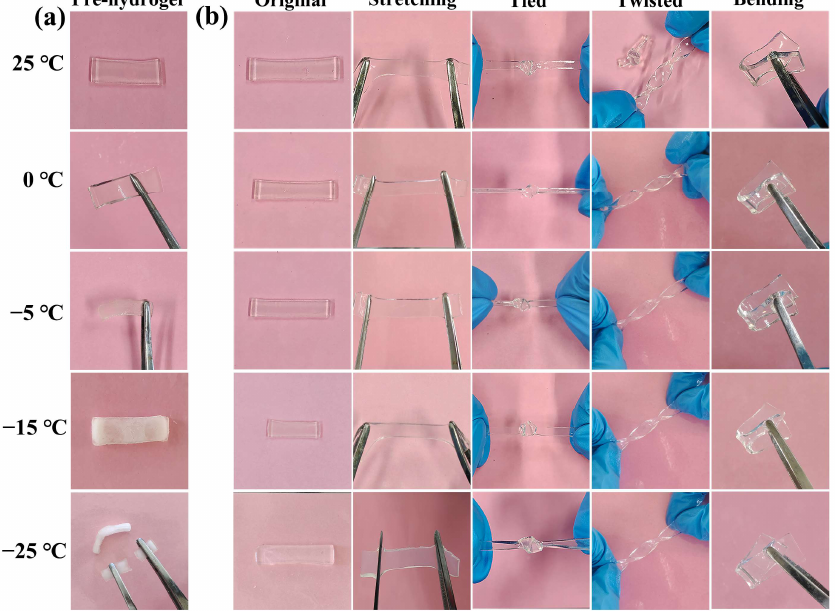
Figure 6. Optical images of hydrogels at 25 °C, 0 °C, −5 °C, −15 °C, −25 °C, respectively. ( a ) The pre-hydrogel with the monomer molar ratio of 5:5; ( b ) N 5 H 5 L organohydrogel of original, stretching, tied, twisted, and bending, respectively.